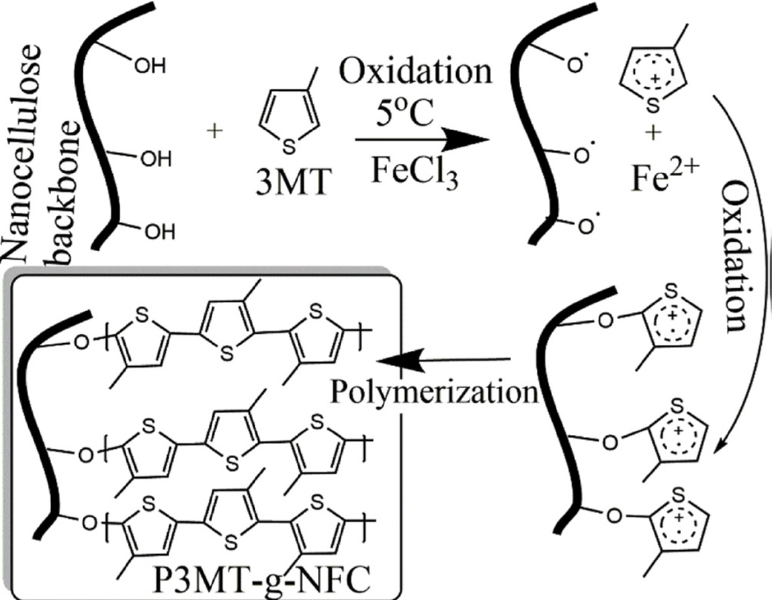
Figure 9. Grafting and polymerization mechanism between polythiophene and CNF. Reproduced from ref. [108].